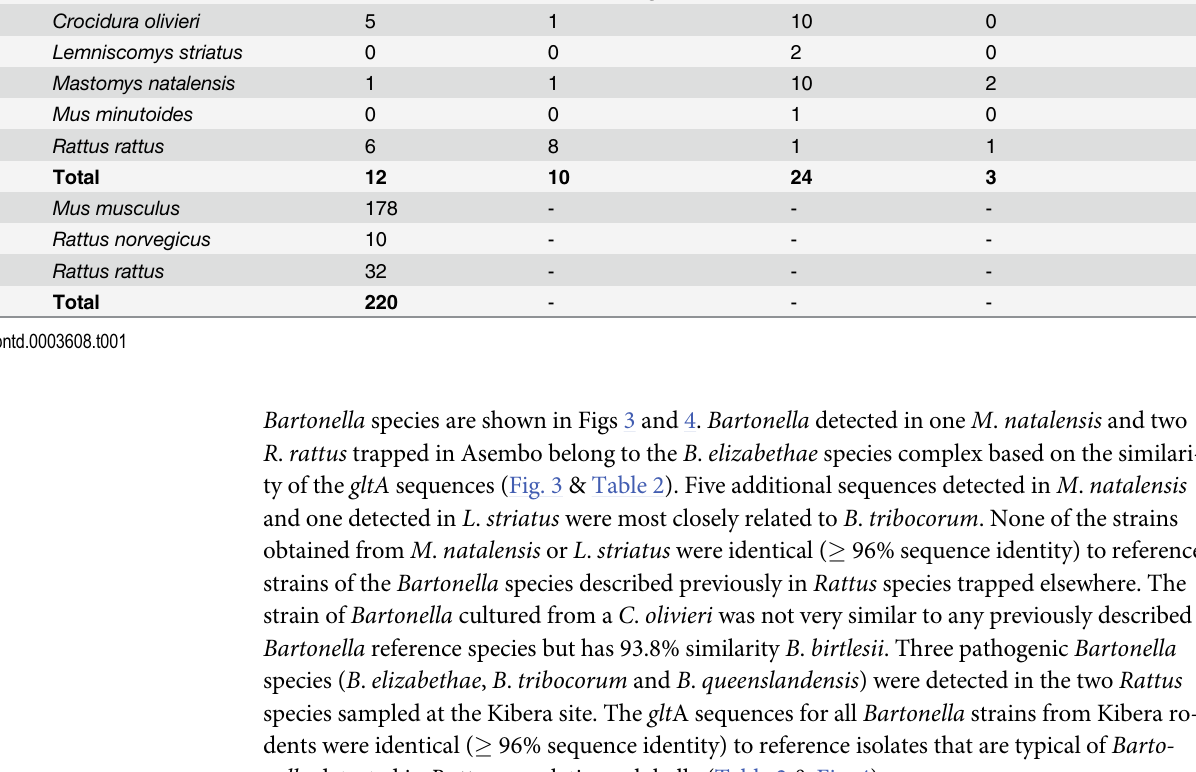
Table 1. Summary of the species and number of small mammals trapped at different locations in the two study sites that were tested for Bartonella .